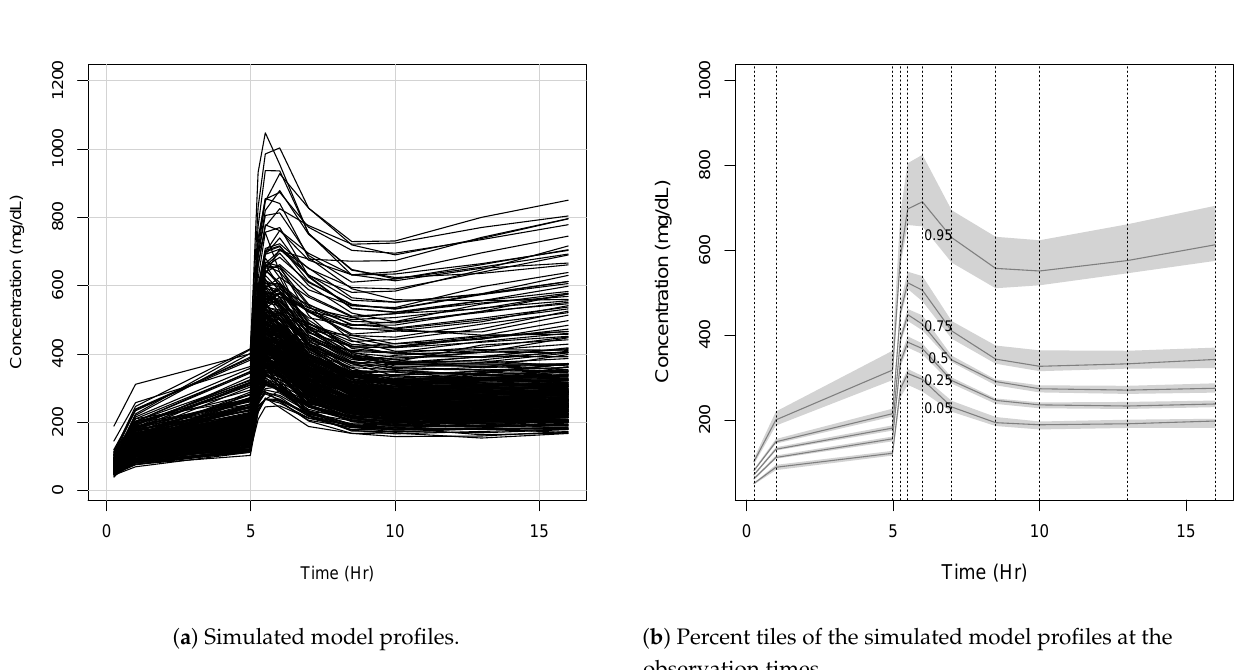
( b ) Percent tiles of the simulated model profiles at the observation times. Figure A2. The 300 simulated observed profiles, frame a, are generated in Pmetrics using the function SIMrun() . The 0.05, 0.25, 0.5, 0.75, and 0.95 percent tiles of the profiles are plotted in frame b, with the CI 95% in grey. The observation times are marked by a vertical dotted line in frame b. Other details are in the text. Of note: inspection of these profiles does not suggest a bimodal elimination parameter.